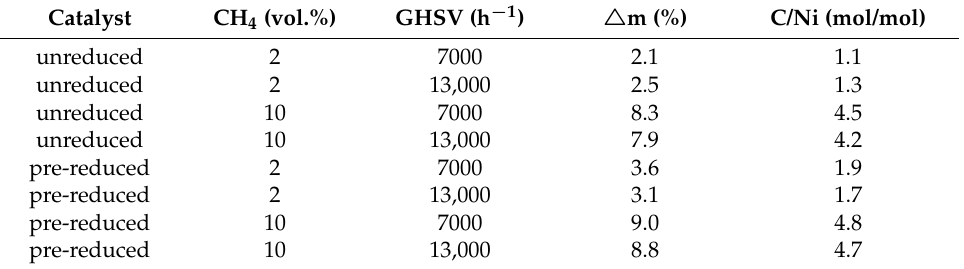
Table 1. Increase in Ni/CeZrO 2 mass after tests of CH 4 decomposition (T = 700 ◦ C; t = 1 h).